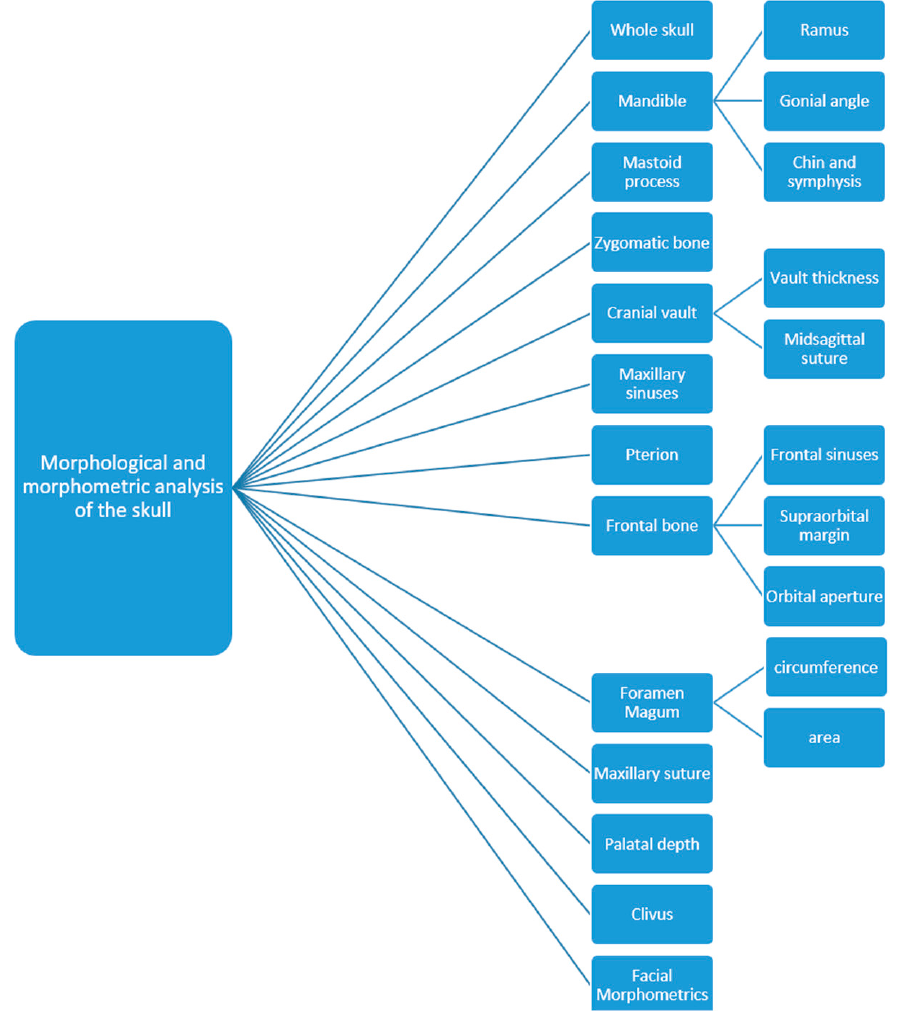
Figure 2. Parts of the skull used for sex estimation.